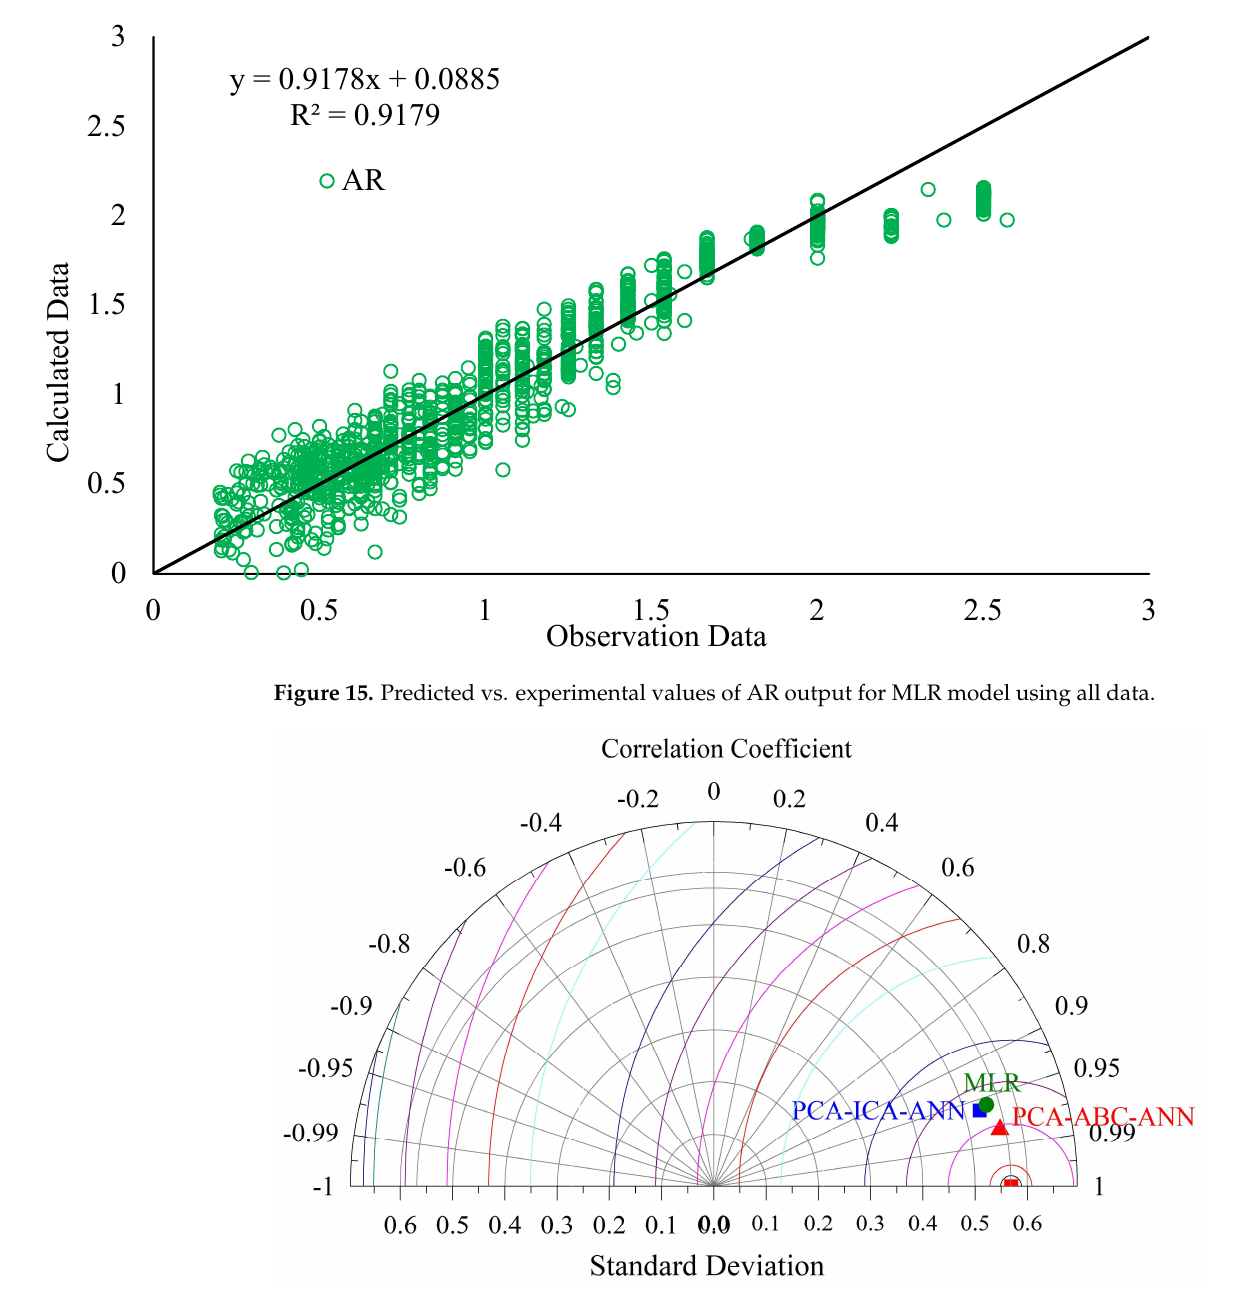
Figure 16. Taylor diagram visualization of the model performance in AR.